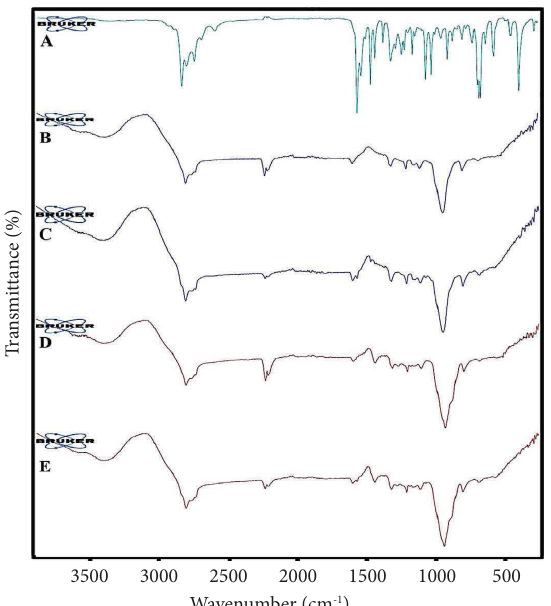
Figure 3: ATR-FTIR spectrums of (A) C . cyminum EO, (B) nanoemulsion (-oil), (C) nanoemulsion, (D) nanogel (-oil), and (E) nanogel.